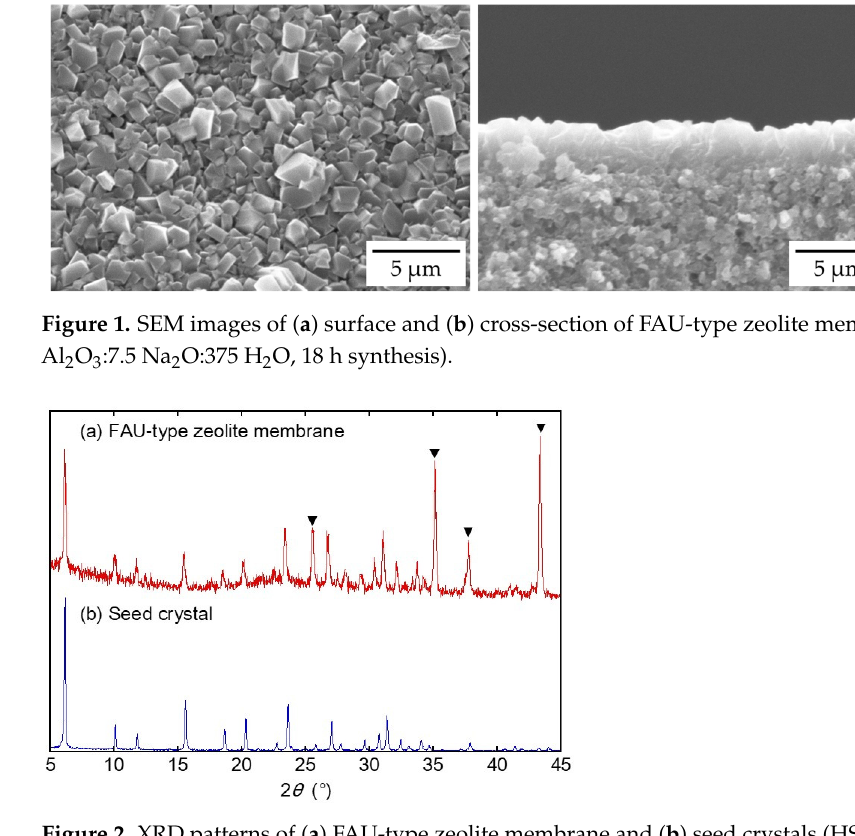
Figure 2. XRD patterns of ( a ) FAU-type zeolite membrane and ( b ) seed crystals (HSZ-320NAA). The triangle symbol ( ▼ ) represents XRD peaks of the α -alumina